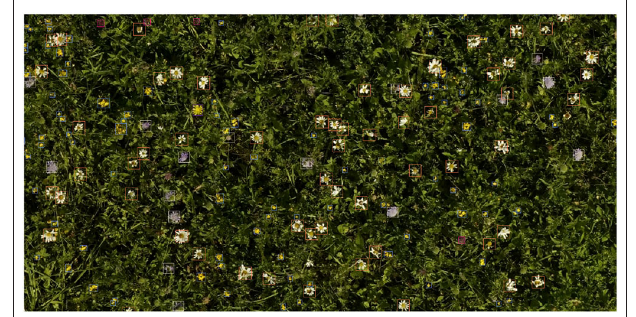
FIGURE 10 | Typical prediction